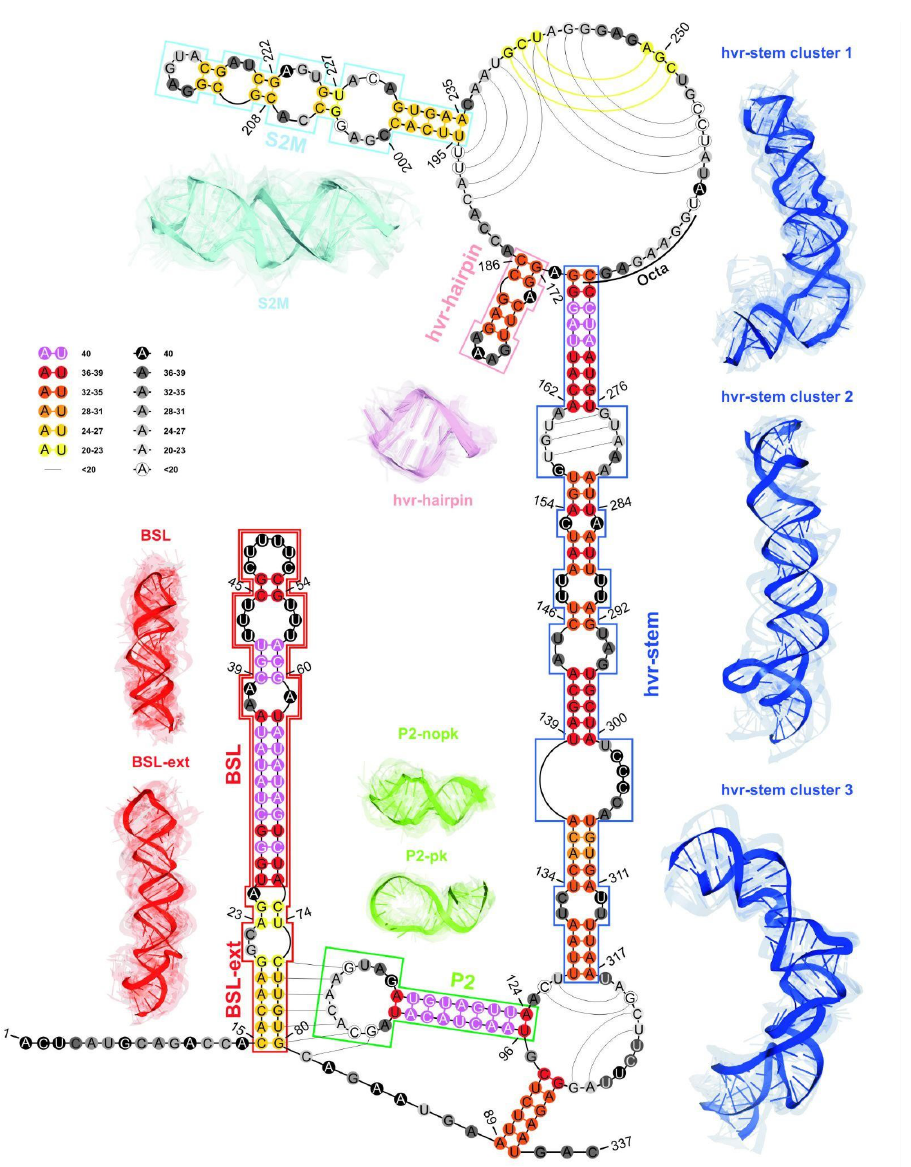
Figure 8. The consensus-driven secondary structure for the 3 (cid:48) -UTR region. Domains: BSL (red), P2 (green), HVR hairpin (light purple), S2M (cyan), and HVR stem (blue). Paired regions are coloured according to the preservation of base pairs in all considered 3D RNA models, from magenta (paired in 100% of models) to yellow (paired in ≥ 50% of models). Unpaired regions are coloured according to the probability that a given residue is not paired in all analysed models, from black (unpaired in 100% of models) to white (unpaired in ≥ 50% of models). Regions are bordered according to their colouring in 3D models. The centroid of each cluster is solid, and the remaining ensemble members are transparent. The 3D models for the HVR domain are shown for the top three clusters. The P2 domain is shown for two sets of models, pseudoknotted and